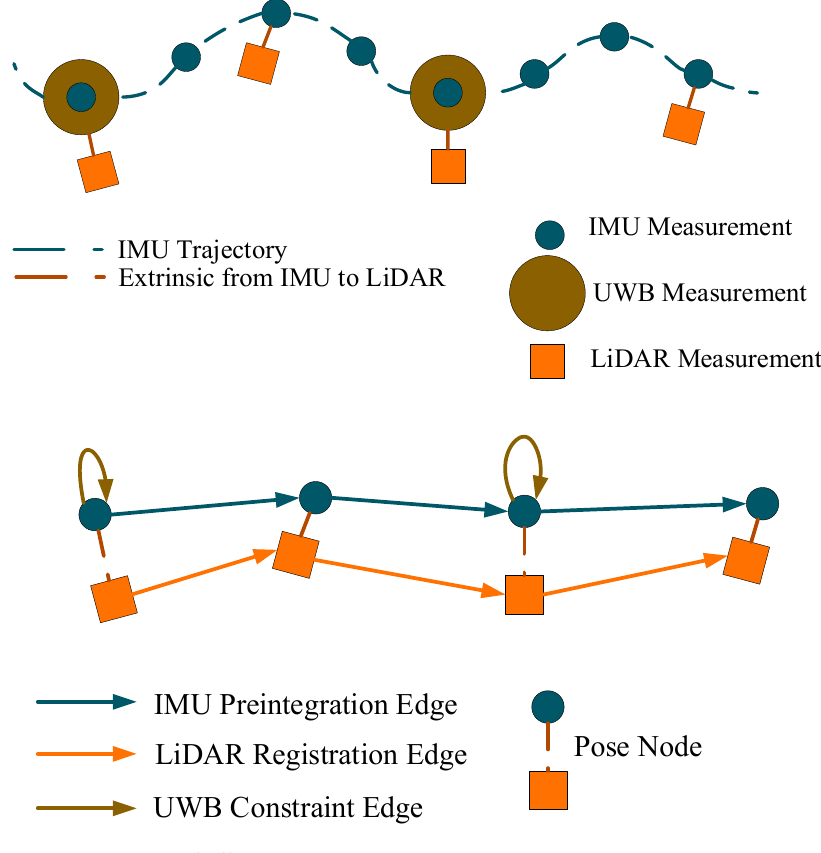
Figure 3. Pose graph